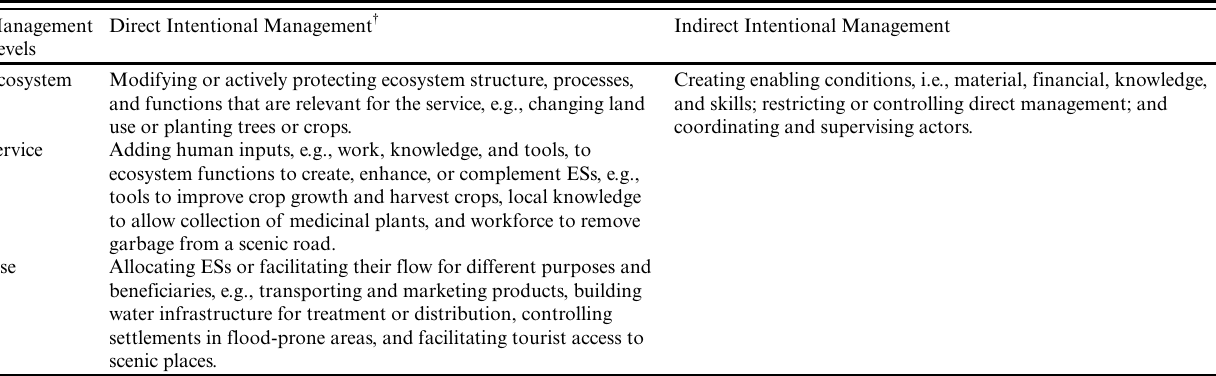
Table 2 . Different forms of ecosystem service (ES)